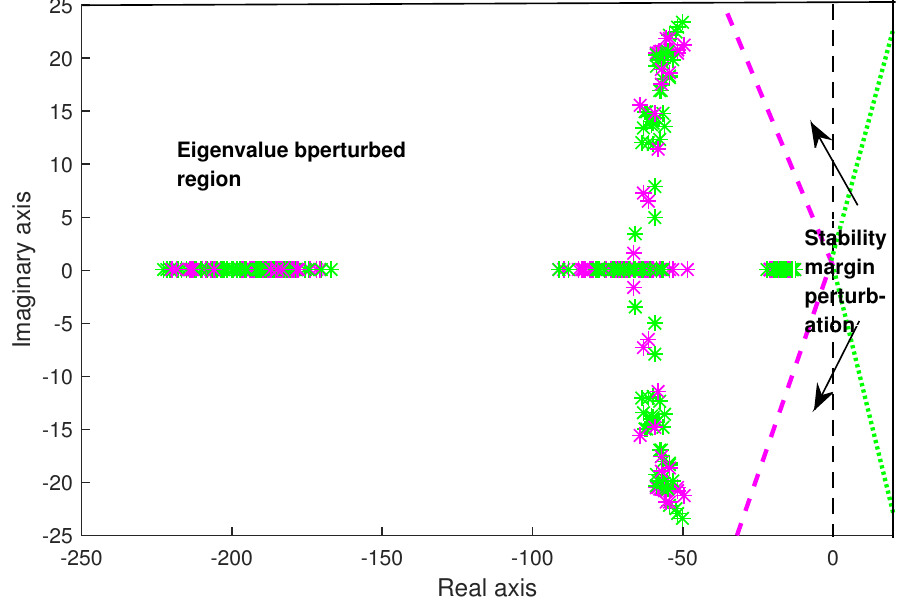
Figure 5. Eigenvalue perturbed region of system (2) in Example 1 with ν ( σ ) ∈ [ 0.9,1.4 ]